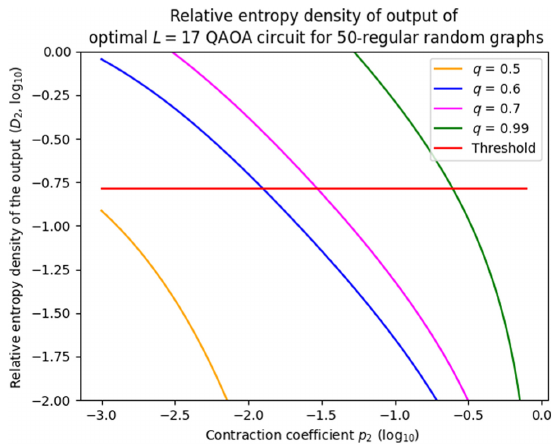
FIG. 2. Relative entropy density of the output of a QAOA cir- cuit of P = 17 layers for various fixed points τ ⊗ n of the contraction coefficient and D = 50. We use the optimal parameters found in Ref. [76] for our circuit. The threshold we use is that in Eq. (68) and we use Corollary C.1 to estimate